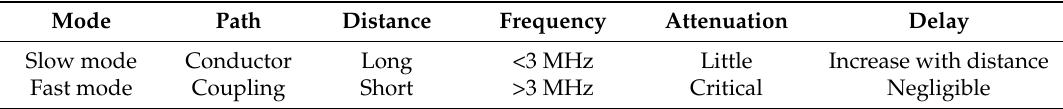
Table 2. Characteristics of Two Propagation Modes of PD Signal in Stator Winding